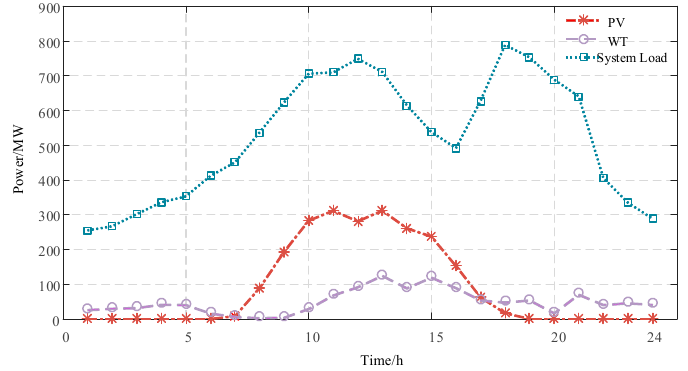
Figure 5. Wind and PV forecast output curve and system load forecast curve. Table 1. Operation Cost Coefficient and Maintenance Cost Coefficient of Wind Power and PV Power Generation.